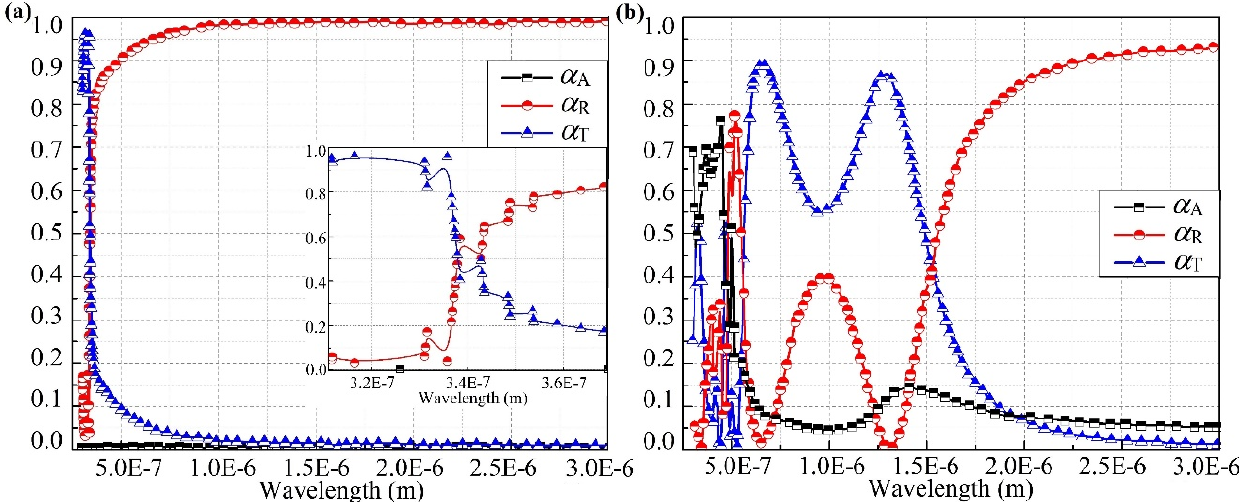
Figure 7. ( a ) The absorptance, reflectivity and transmissivity of Infinite plate; ( b ) The absorptance, reflectivity and transmissivity of periodic cubic frame silver.